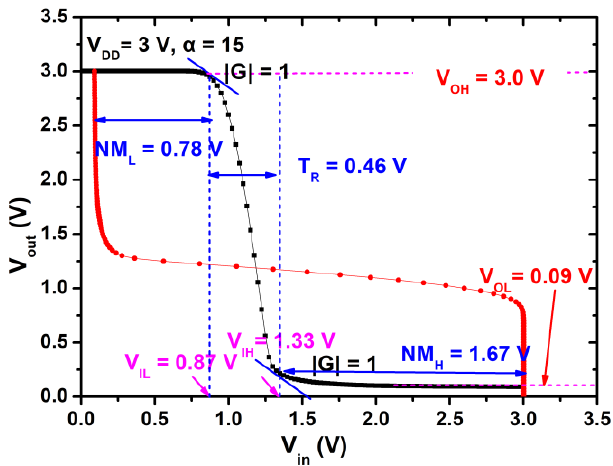
Figure 5. Static voltage transfer characteristics of the inverter with α = 15 measured at supply voltage V DD = 3 V.